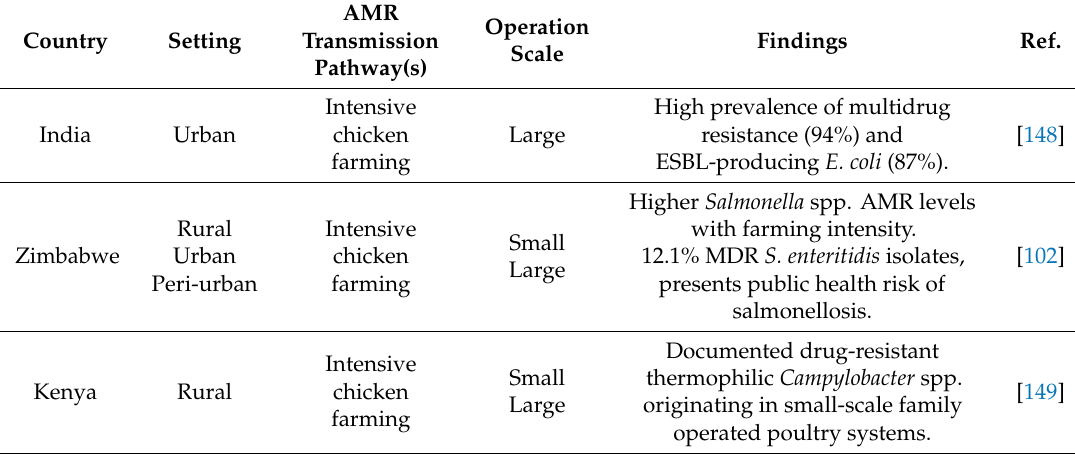
Table 4. Overview of antimicrobial resistance (AMR) transmission pathways originating from poultry production within resource-limited